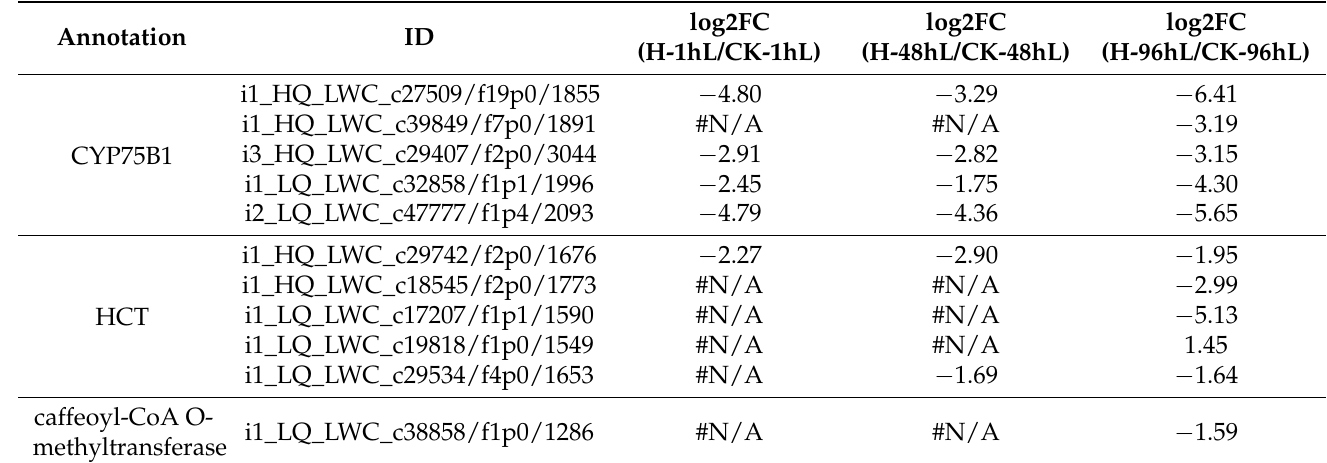
treatment. Figure S2. Correlation between samples. Figure S3. Changes of peroxidation scavenging enzyme activity of pearl millet under heat stress. (a) Changes of SOD activity in pearl millet under heat stress. (b) Changes of APX activity in pearl millet under heat stress. * represents p < 0.05, **** represents p < 0.0001. Table S1. Overview of the sequencing results of 18 samples. Table S2. The expression and functional annotation of DEGs in pearl millet after 1 h, 48 h and 96 h heat stress. Table S3. GO enrichment of pearl millet after 1 h, 48 h and 96 h heat stress. Table S4. KEGG enrichment of pearl millet after 1 h, 48 h and 96 h heat stress. Table S5. GO enrichment analysis after K-means clustering. Table S6. KEGG enrichment analysis after K-means